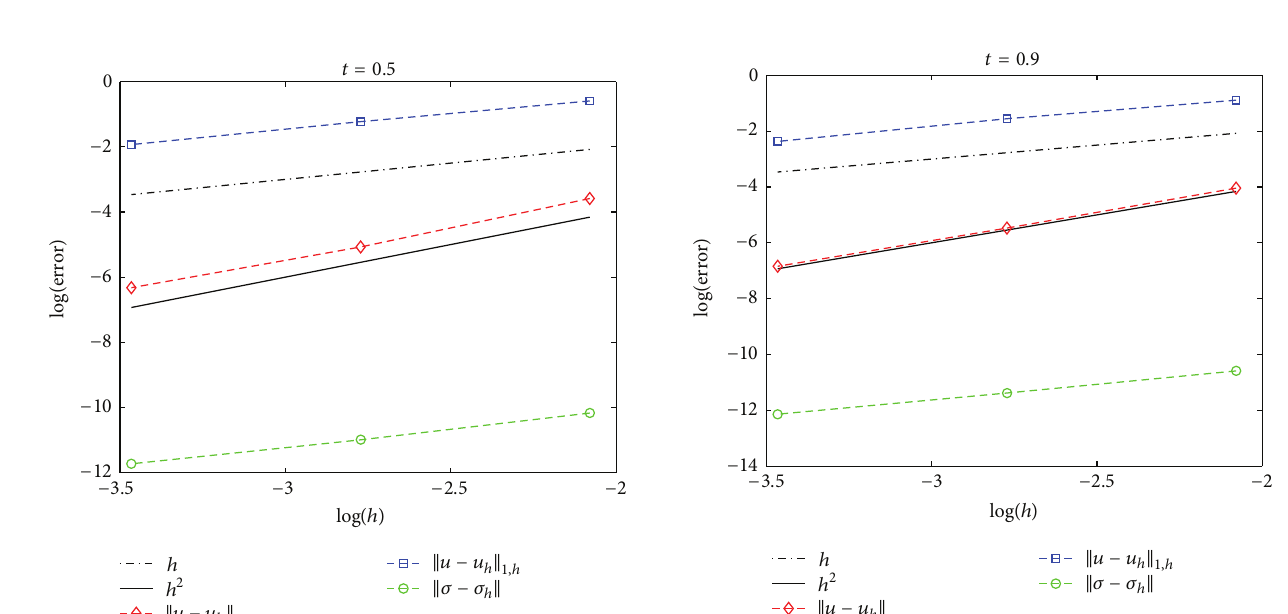
Figure 2: Errors at 𝑡 = 0.5 .